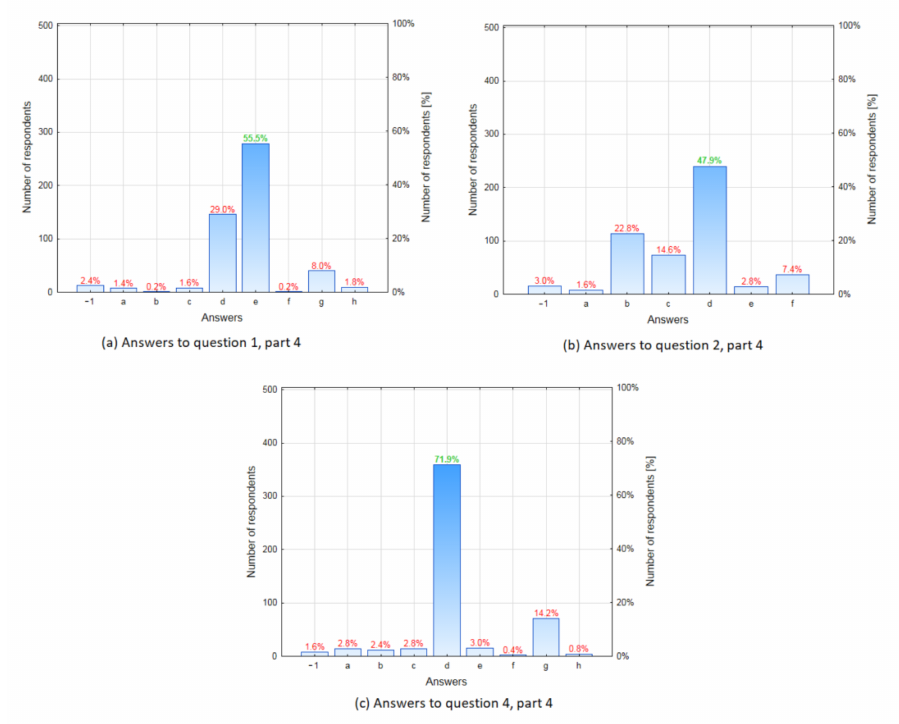
Figure A3. ( a – c ) Answers to part 4 of the survey. The most recommended answers are marked green, and other answers are marked